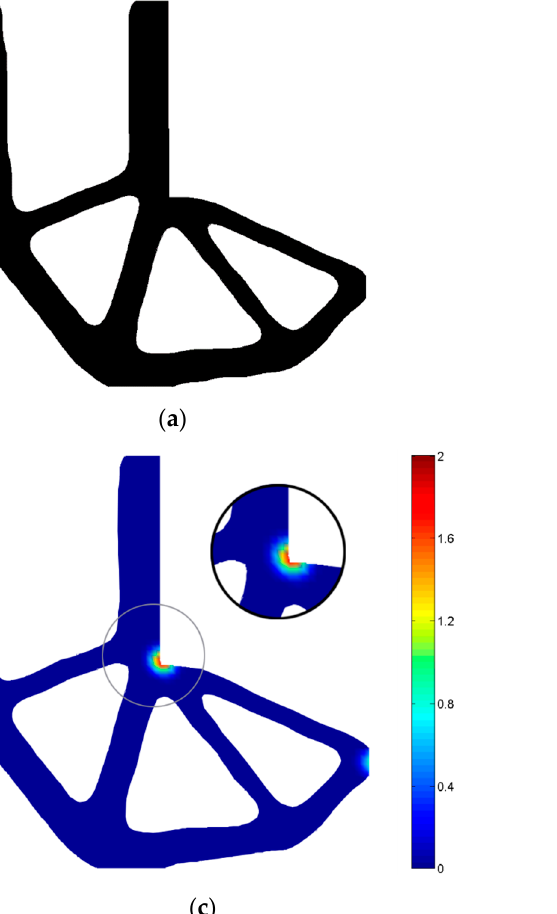
Figure 7. Optimization results and porosity constraint distribution clouds of L-shaped beam, ( a ) optimized shape without considering porosity constraint; ( b ) optimized shape considering porosity constraint; ( c ) porosity constraint distribution clouds without considering porosity constraint; ( d ) porosity constraint distribution clouds considering porosity constraint.